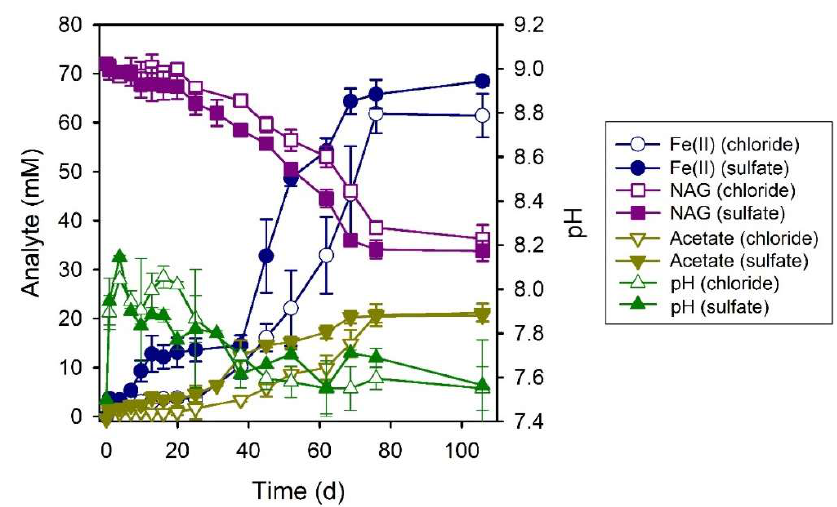
Figure 9. Fe(II) and acetate production, N -acetylglucosamine (NAG) consumption, and pH during the bioreduction of lepidocrocite by S. putrefaciens CN32 with NAG as the electron donor.